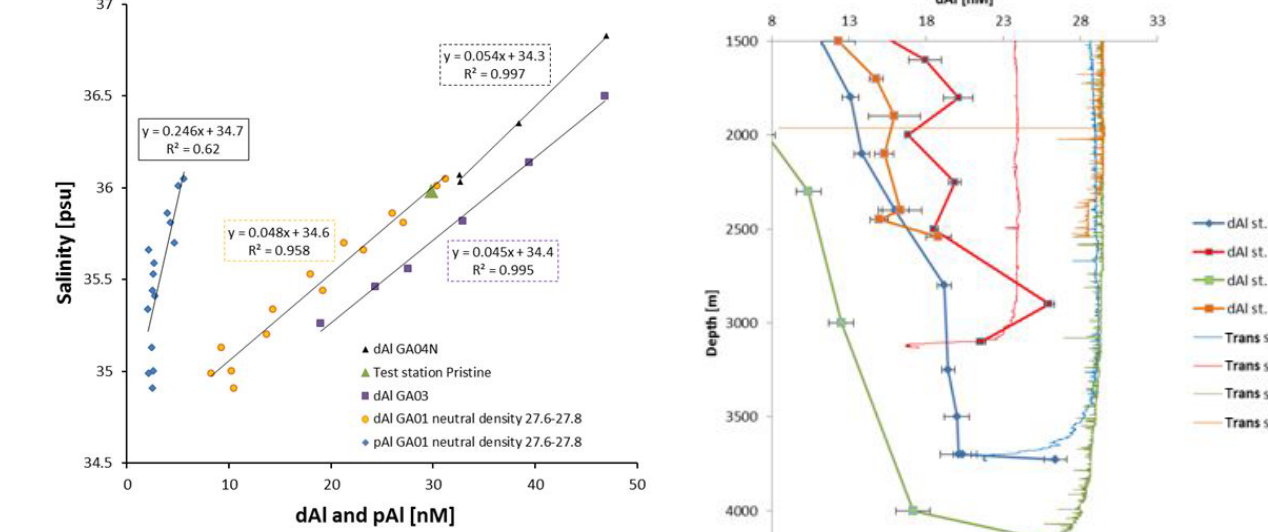
Figure 8. Dissolved Al and particulate Al (pAl; Gourain et al., 2018) concentrations against salinity for the Mediterranean Out- flow Water (MOW) between the neutral-density layer 27.6 and 27.8kgm − 3 . GA03 (Measures et al., 2015), GA04N (Rolison et al., 2015), and test station Pristine (Rijkenberg et al., 2015).